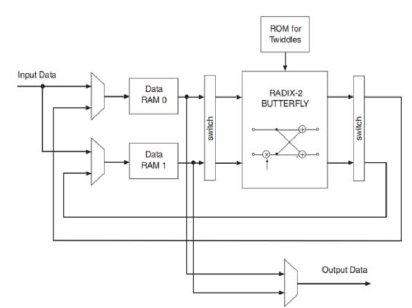
Fig 4. Diagram of radix-2 FFT processing